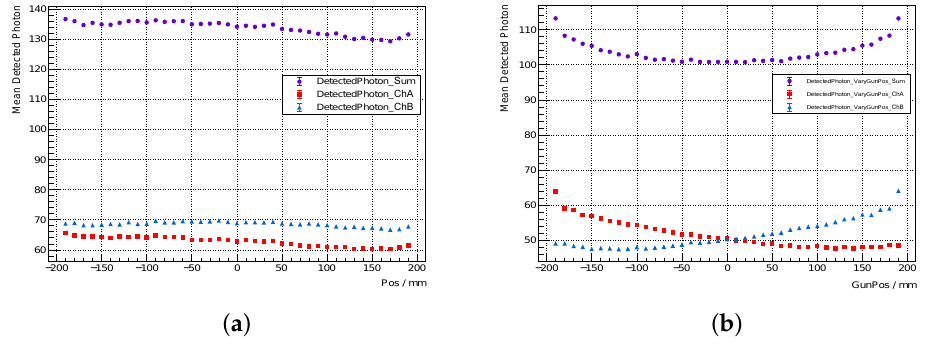
Figure 11. Uniformity scan for a 40 cm long BGO crystal bar. ( a ) Measured response uniformity with Cs-137. ( b ) Simulated response uniformity with 662 keV